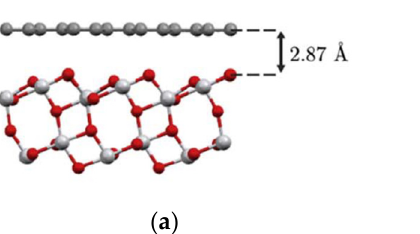
Figure 9. Interaction with the (101) surface of anatase of graphene ( a ) and graphene oxide ( b ). Reproduced with permission from Reference [95]; copyright (2018) Elsevier.